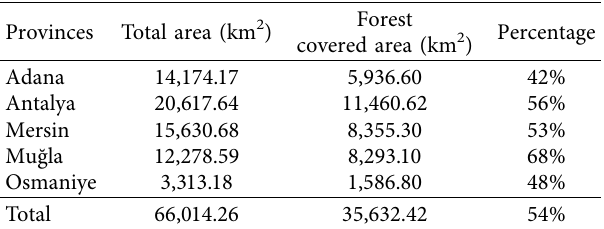
Table 1: Forest areas and rates by province (http://www.ogm.gov.tr).